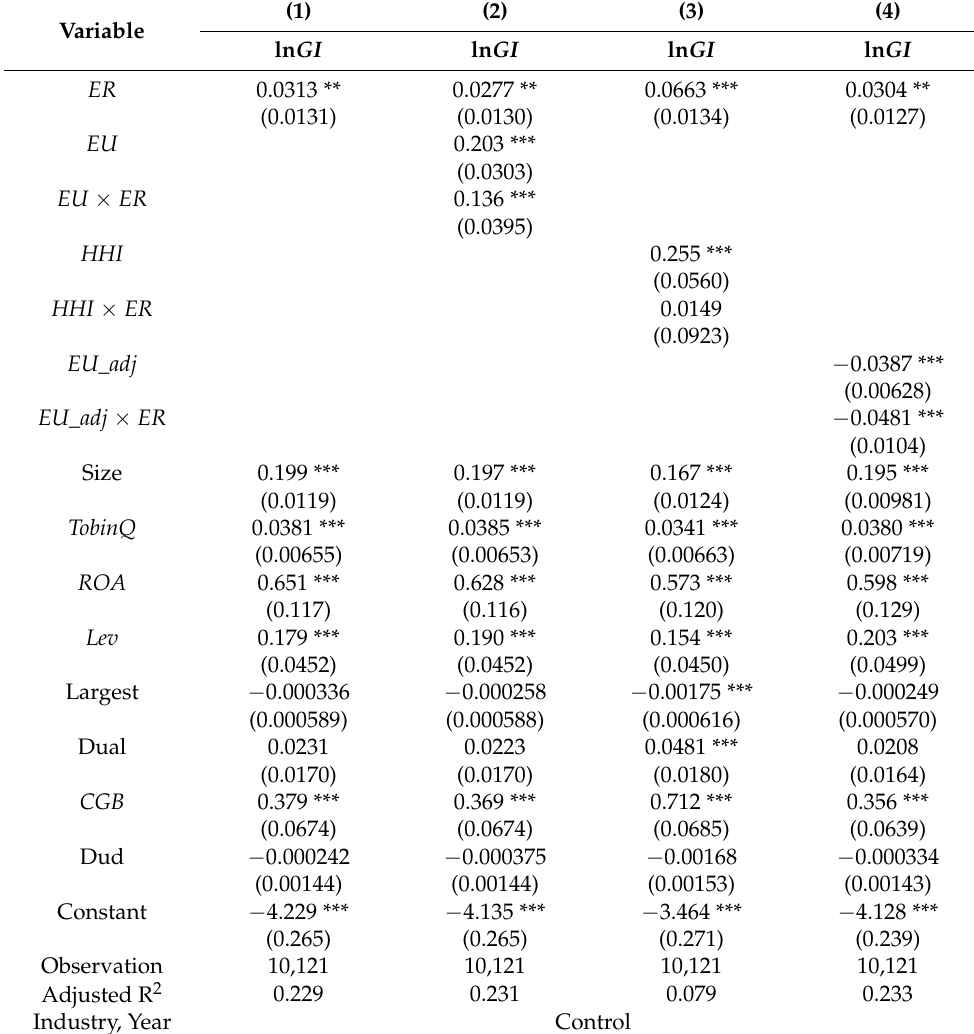
Table 10. Regression Analysis of Environmental Uncertainty, Environmental Regulation and Enter- prises’ Green Technological Innovation of